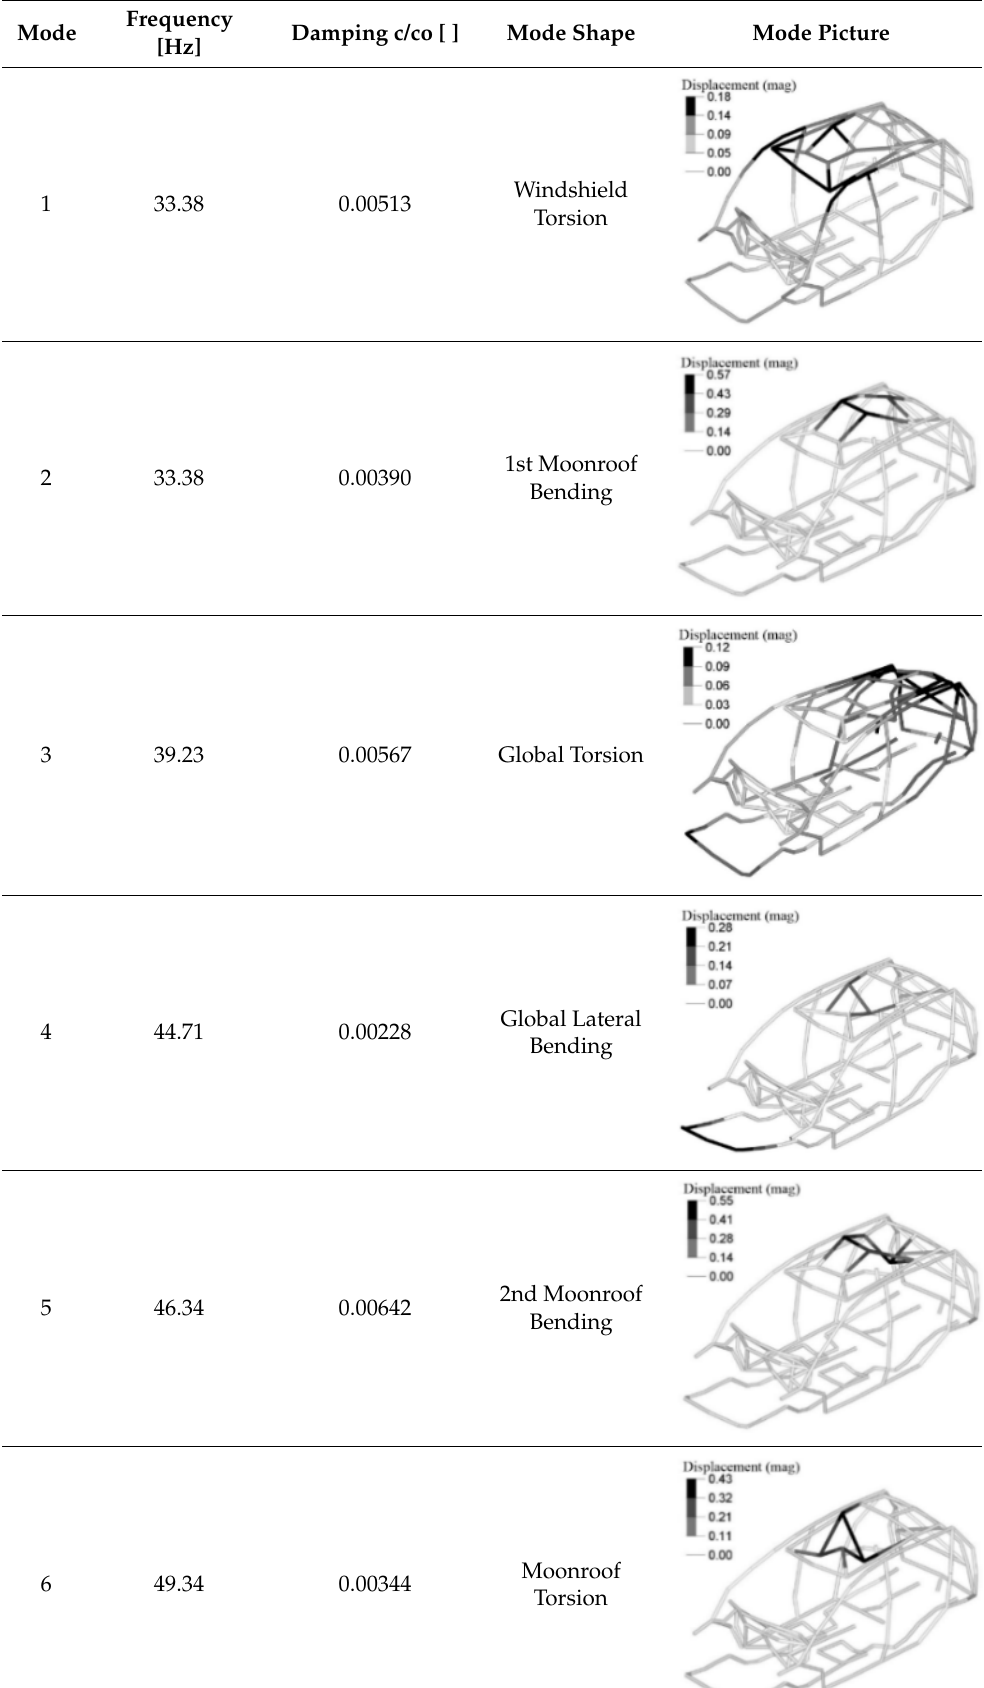
Table 1 gathers the eigenfrequencies and damping ratios of the main eigenmodes of the body structure found in the bench test, from 10 to 60 Hz. Table 1. Eigenfrequencies and damping ratios of the vehicle body structure from the bench test. Mode Frequency [Hz] Damping c/co [ ] Mode Shape